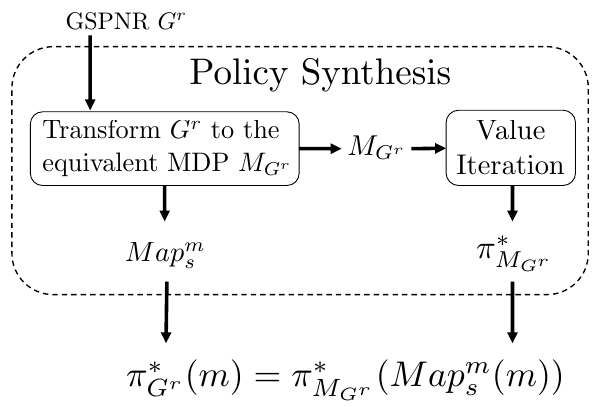
Figure 5. Diagram summarizing the policy synthesis